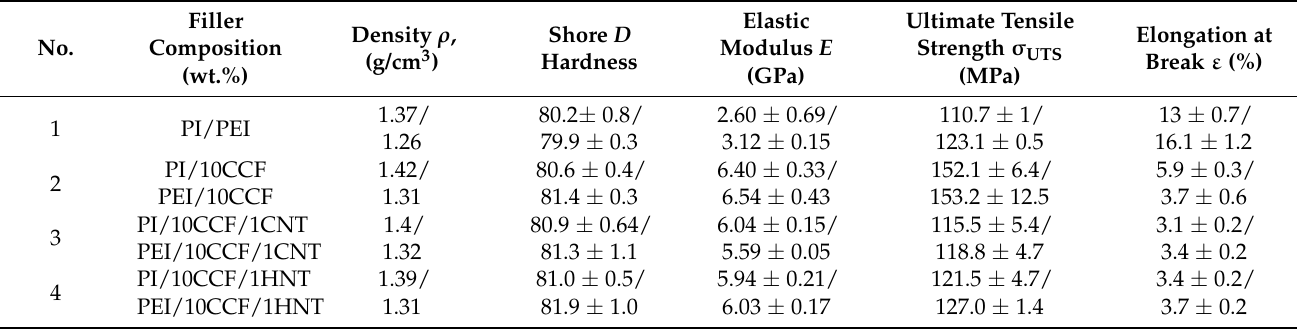
Table 2. The physical and mechanical properties of neat PI and PEI, as well as the PI- and PEI-based nanocomposites.